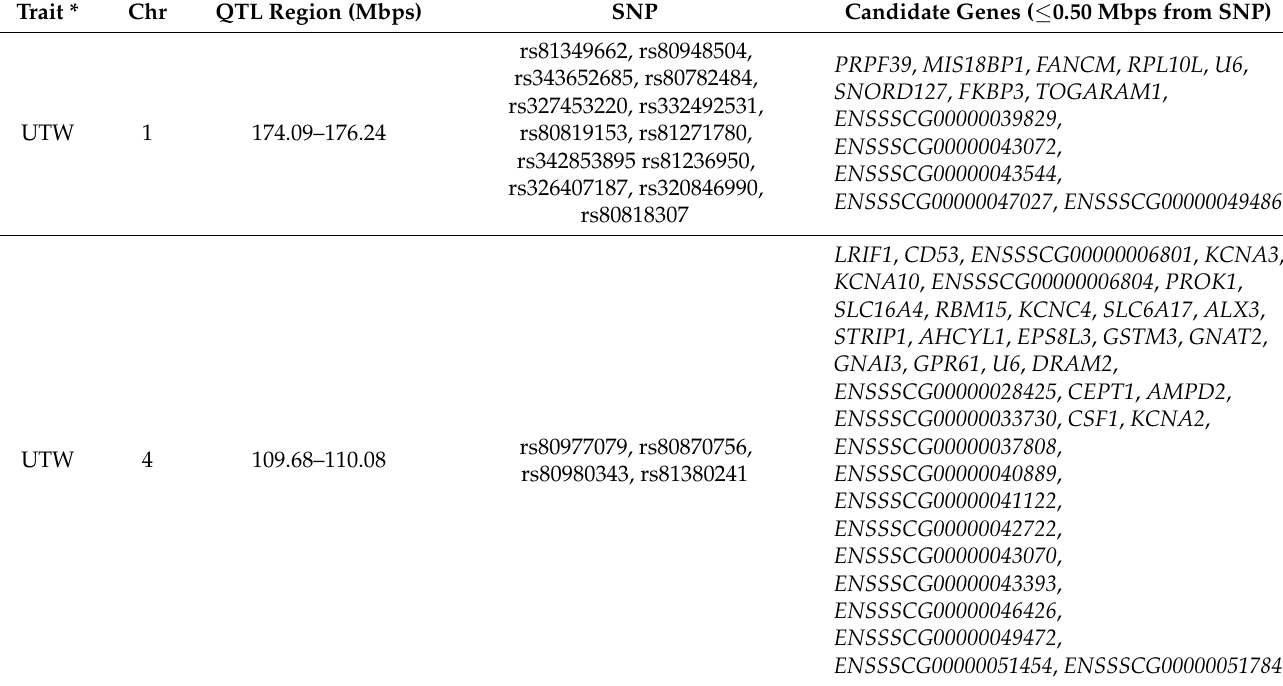
Table 4. Summary of SNP windows that explained >1% of genetic variance for untrimmed thigh weight, with a list of positional candidate genes for each SNP ( ≤ 0.50